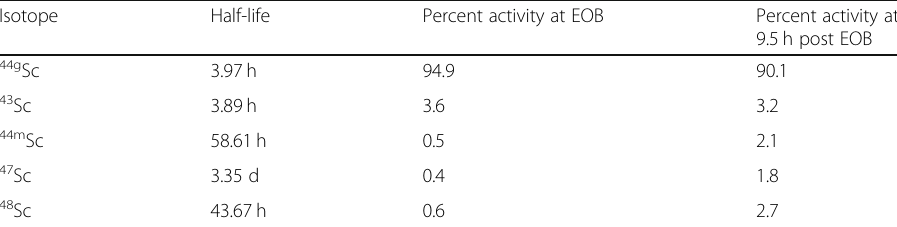
Table 1 Radioisotopic composition of radioscandium from the irradiation of natural calcium targets with 16 MeV protons